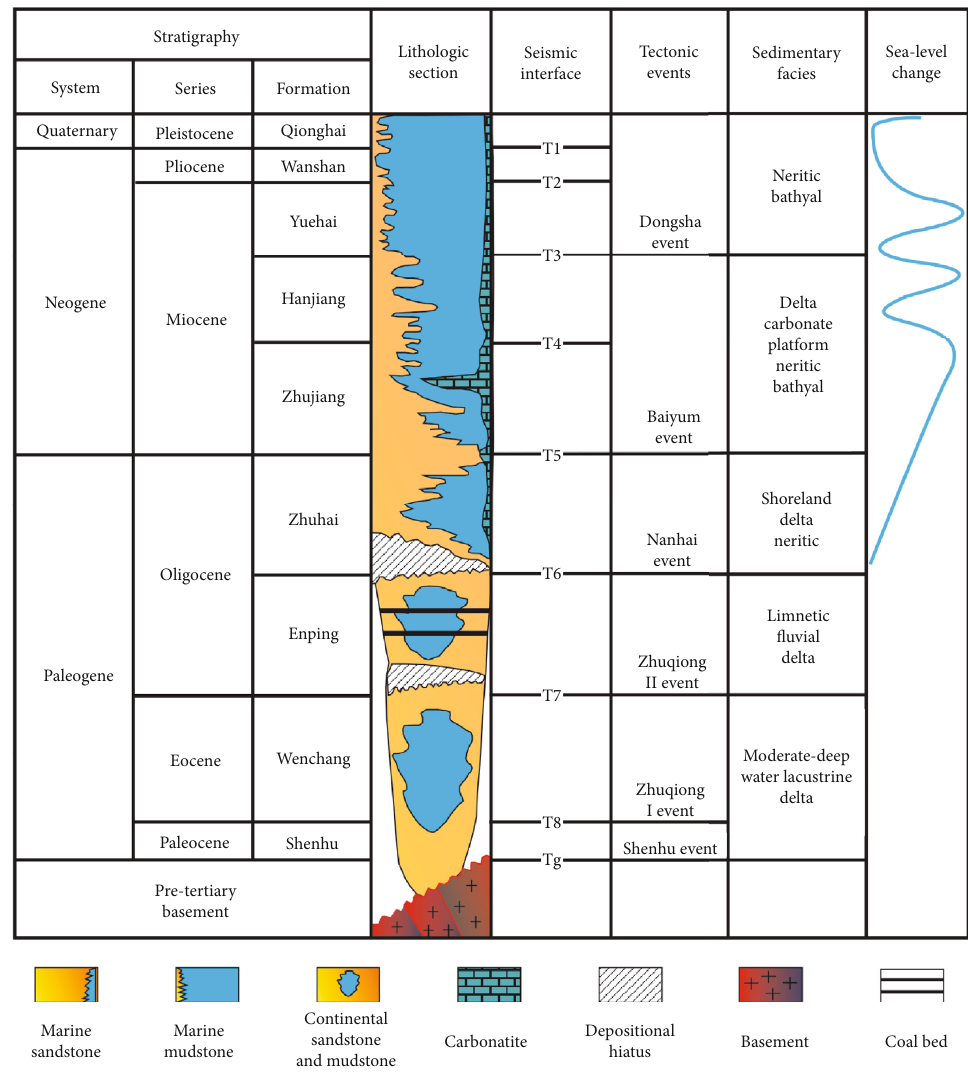
Figure 2: Comprehensive stratigraphic histogram of the Pearl River Mouth Basin.